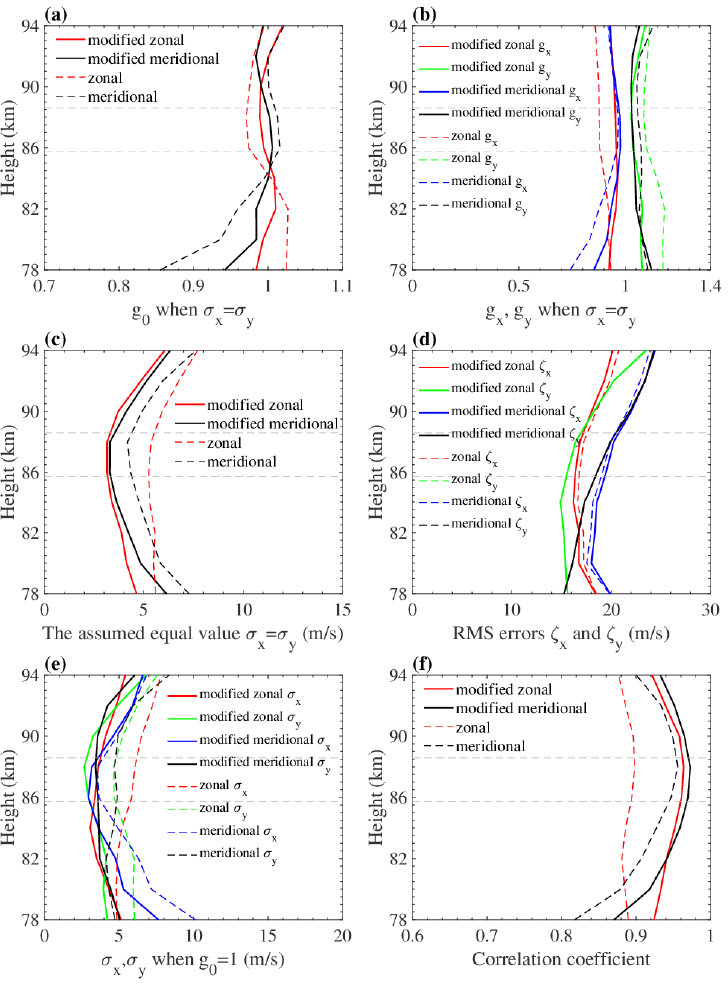
Figure 8. Summary of the numerical parameters for the wind measurements at heights of 78–94 km after correcting the angular reference direction. ( a ) optimal slope g 0 assuming that σ x = σ y ; ( b ) slopes of the least squares regression fits of the 53.1 MHz MR results against the 37.5 MHz MR results and of the 37.5 MHz MR results against the 53.1 MHz MR results; ( c ) results obtained by assuming equal values σ x and σ y ; ( d ) RMS continuous errors of the two systems; ( e ) σ x and σ y when g 0 = 1; ( f ) correlation coefficients between the two MR measurements. The red and green lines correspond to the zonal component, and the blue and black lines correspond to the meridional component. The subscripts x and y represent the 37.5 MHz and 53.1 MHz MRs, respectively. The gray dashed lines correspond to the meteor peak height for both MRs. For ease of comparison, the dashed lines represent the results shown in Figure 4, and the meanings of the colors are the same as in Figure